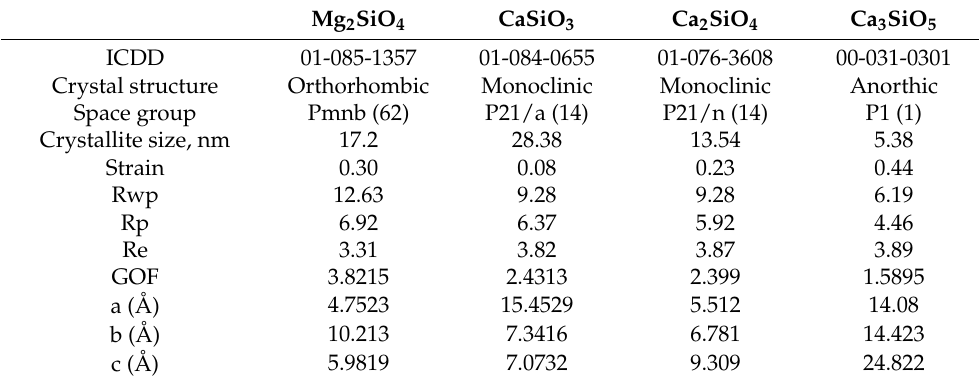
Table 3. Mean crystallite size and structural parameters of the obtained silicate fillers.